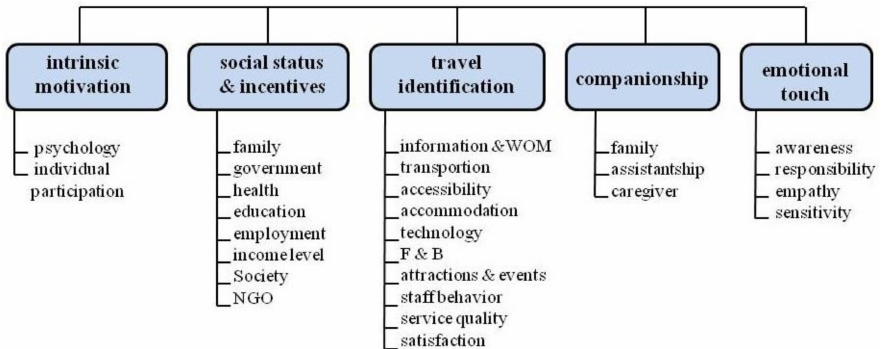
Figure 1. Determinants of travel for wheelchair